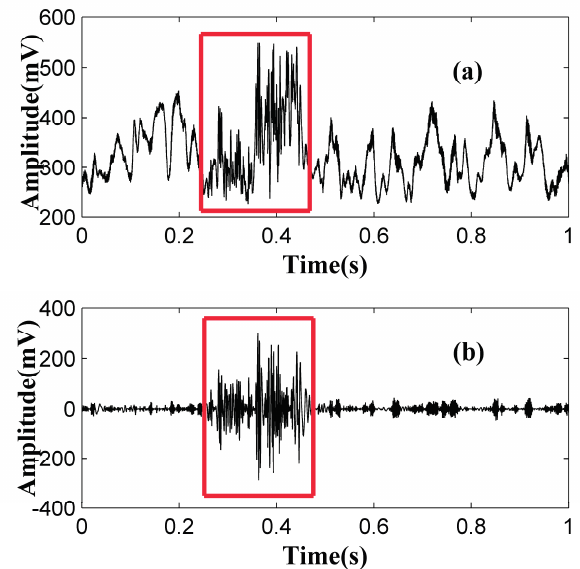
Figure 4. Time series before ( a ) and after ( b ) processing. The red rectangle shows the vibration duration (under 5000 ns pulse